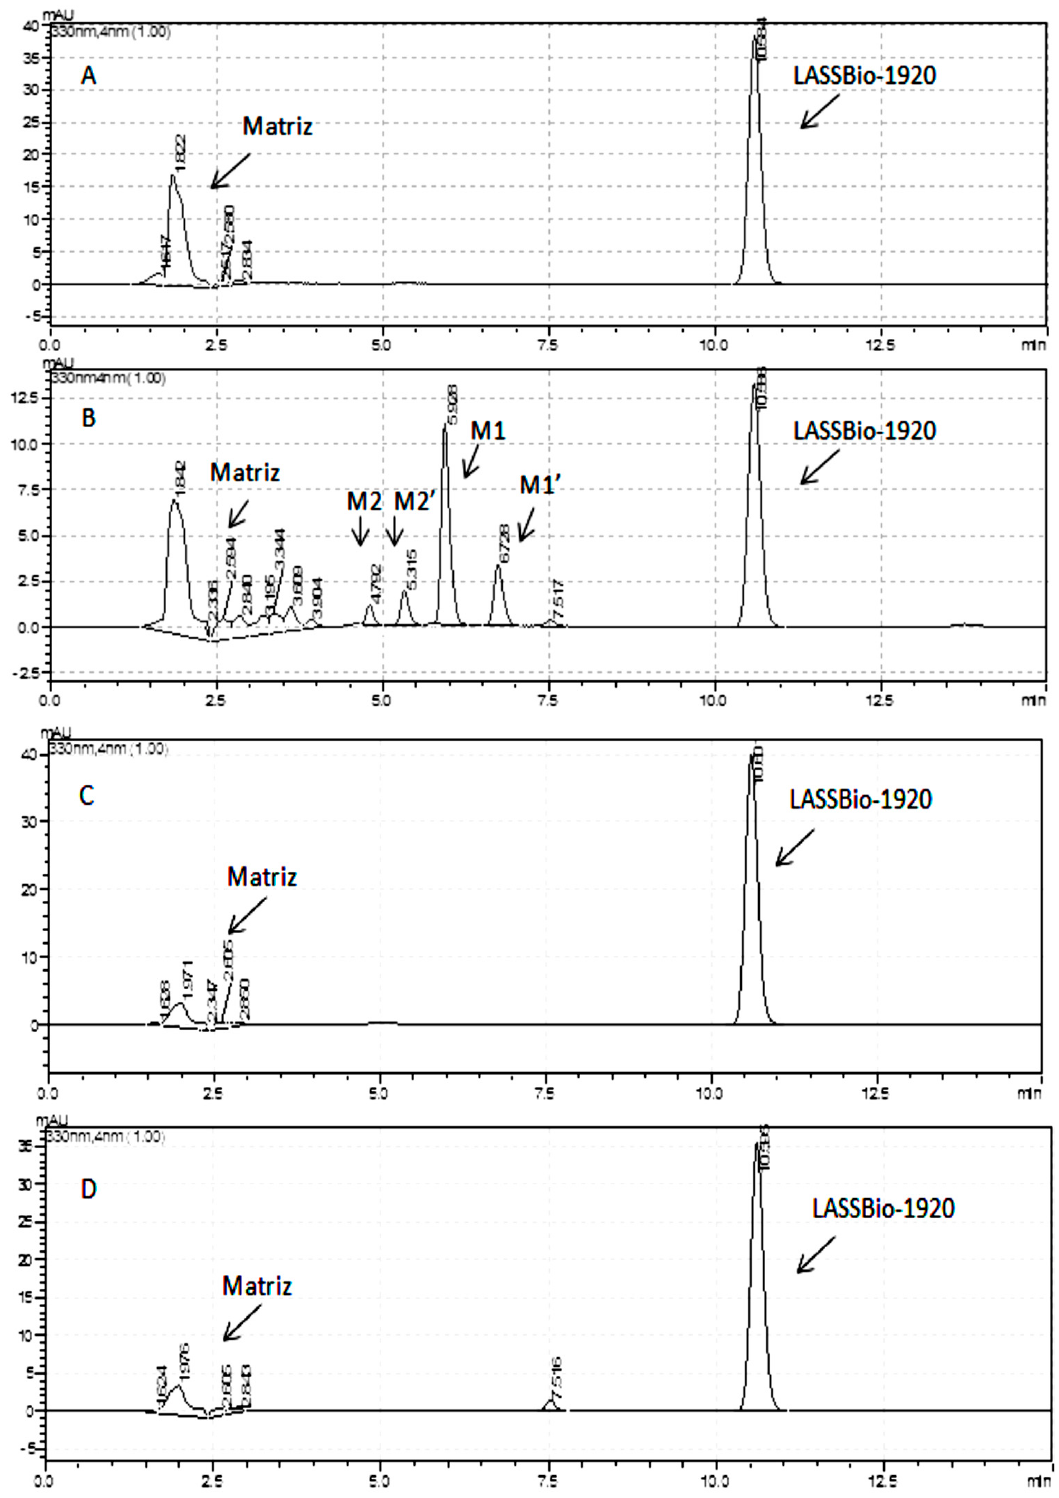
Figure 11. Metabolic analysis of LASSBio-1920 by HPLC/MS. Samples analyzed at 330 nm in triplicate: ( A ) LASSBio-1920, incubation time 0 min in the presence of NADPH − generating system; ( B ) LASSBio-1920, after 120 min of incubation in the presence of an NADPH − generating system; ( C ) LASSBio-1920, time 0 min in the absence of an NADPH generating − system; ( D ) LASSBio-1920, after 120 min of incubation in the absence of an NADPH − generating system. Mobile isocratic phase acetonitrile: water (1:1), 15 min and 1 mL/min.